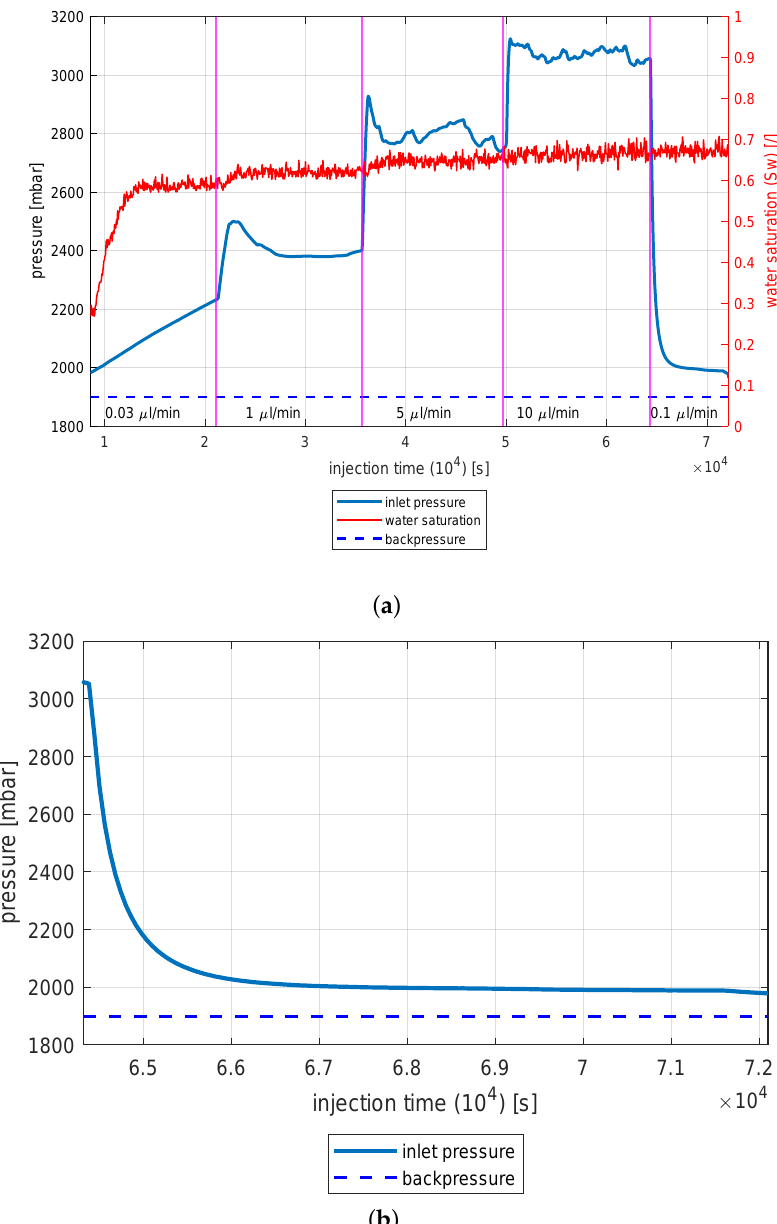
Figure 6. Development of the pressure and the water saturation in the micromodel during water injection. ( a ) depicts the development during the entire waterflooding process; ( b ) shows the pressure curve during the last flow rate of 0.1 µ